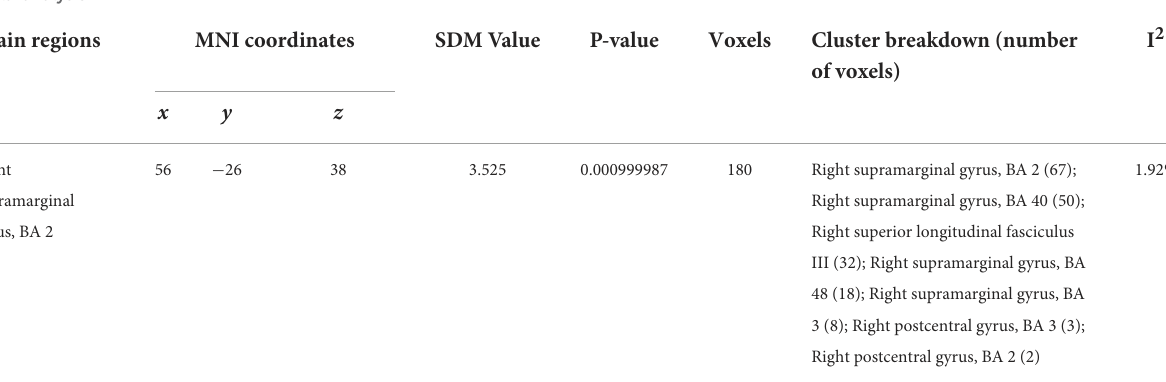
TABLE 5 Regional differences in gray matter volume after acupuncture treatment in MCI patients vs. healthy controls in a coordinate-based meta-analysis. Brain regions MNI coordinates SDM Value